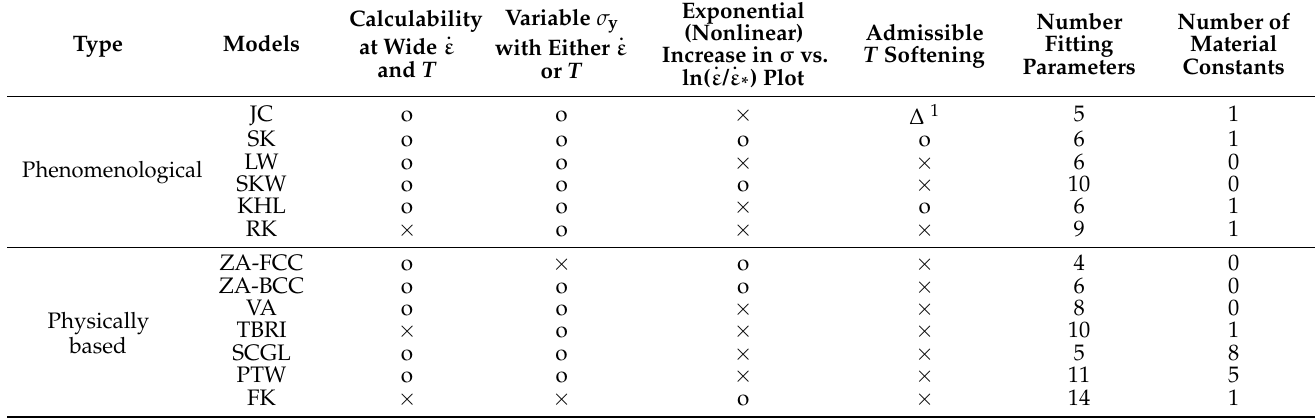
Table 14. Flow stress description characteristics of the considered constitutive models in terms of (i) the . ε and T , (ii) variable σ y with either calculability of the model at wide . (cid:0) . (cid:1) ε / ε ∗ increase in σ with ln (stress upturn), and (iv) admissible temperature softening. The symbols mean that the respective phenomenon is o: described; ∆ : partially described; × : not